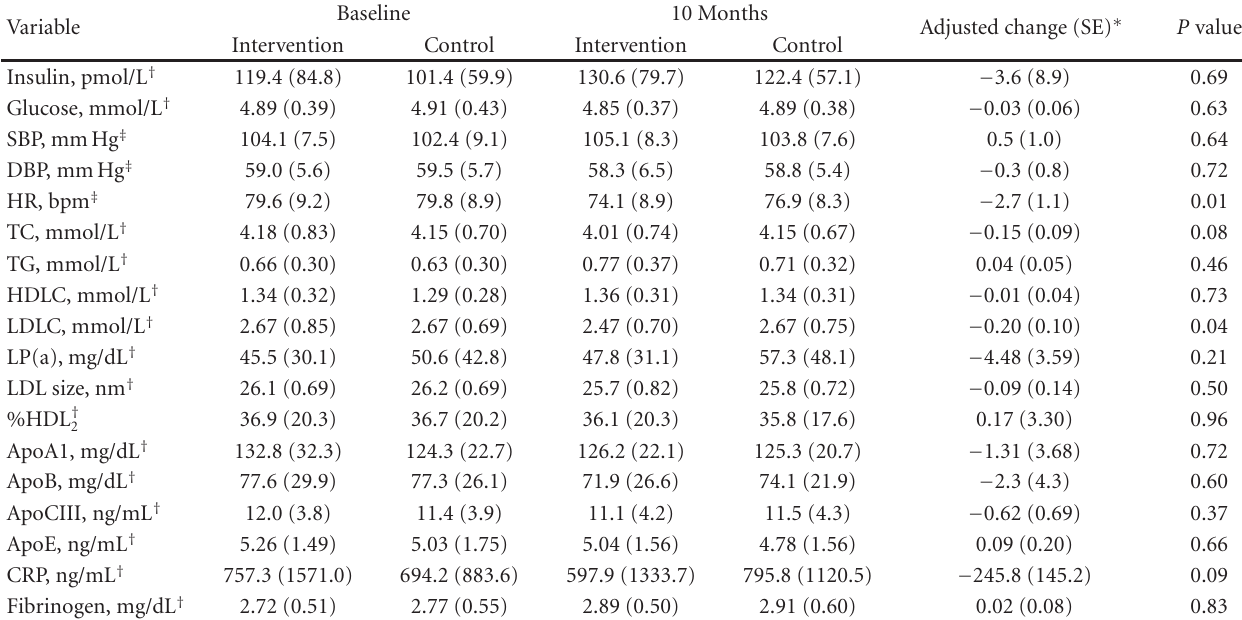
Table 3: Cardiometabolic biomarkers at baseline and at 10 months for the intervention and control groups with all intervention subjects included regardless of attendance at the PA sessions (unadjusted mean [SD]).